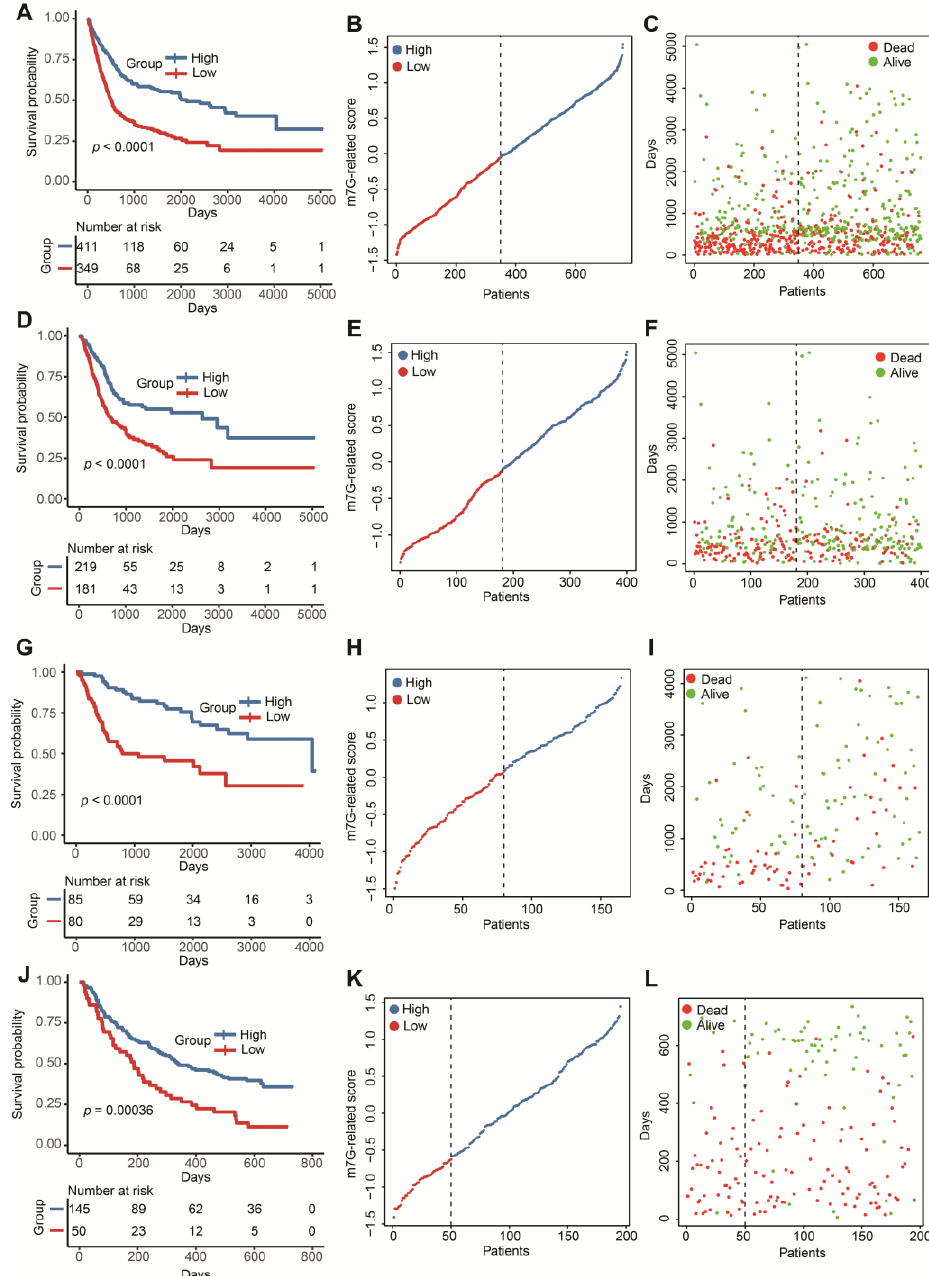
Figure 4. Construction and validation of a m7G-related scoring system. ( A ) The Kaplan–Meier survival analysis of OS between high- and low-score groups in the whole cohort. ( B ) The distribution of m7G-related scores in the whole cohort. ( C ) The relationship between m7G-related signature and survival status in the whole cohort. ( D ) The Kaplan–Meier survival analysis of OS between high- and low-score groups in the TCGA-BLCA dataset. ( E ) The distribution of m7G-related scores in the TCGA-BLCA dataset. ( F ) The relationship between m7G-related signature and survival status in the TCGA-BLCA dataset. ( G ) The Kaplan–Meier survival analysis of OS between high- and low-score groups in the GSE13507 dataset. ( H ) The distribution of m7G-related scores in the GSE13507